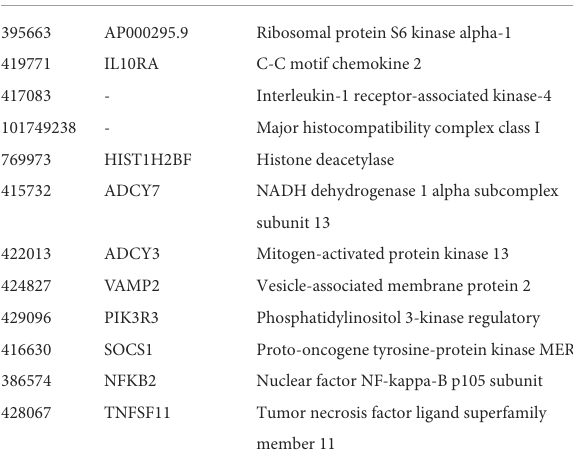
TABLE 1 Targets associated with mixed infection obtained. Gene ID Gene